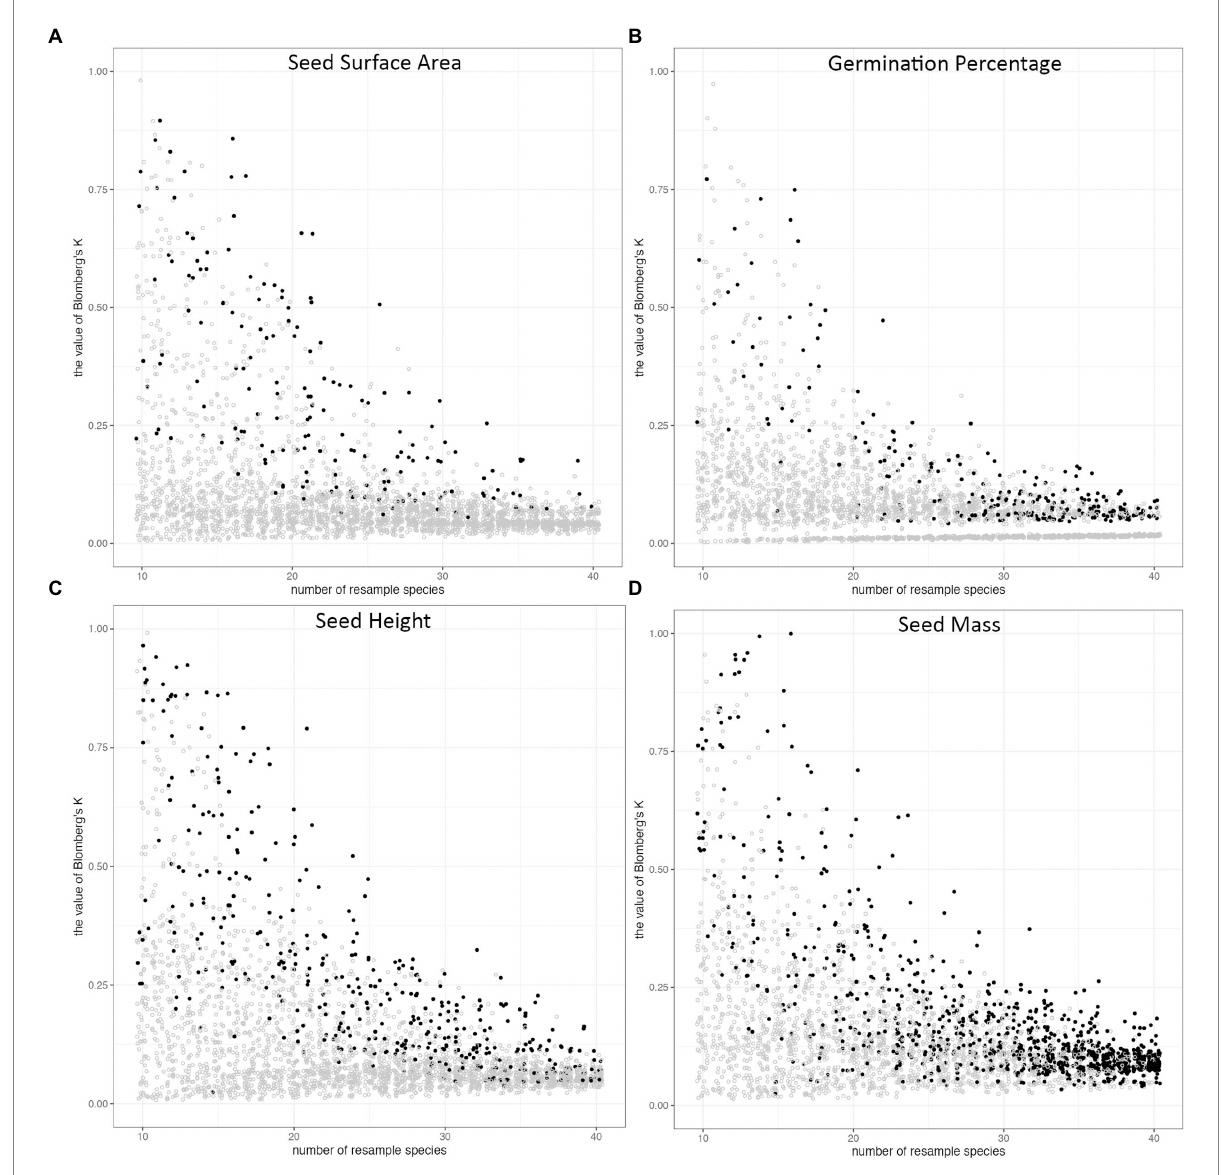
FIGURE 4 The distribution of Blomberg’s K along the size of the species pool in random subsampling tests. The species were resampled 100 times from 10 species to 40 species, and phylogenetic signal (Blomberg’s K) was calculated for each trait, 3100 times for each trait. Phylogenetic signals